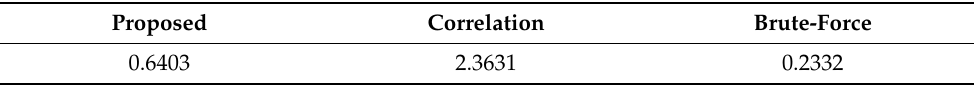
Table 3. Average position errors (in pixels) of the entire Figure 6